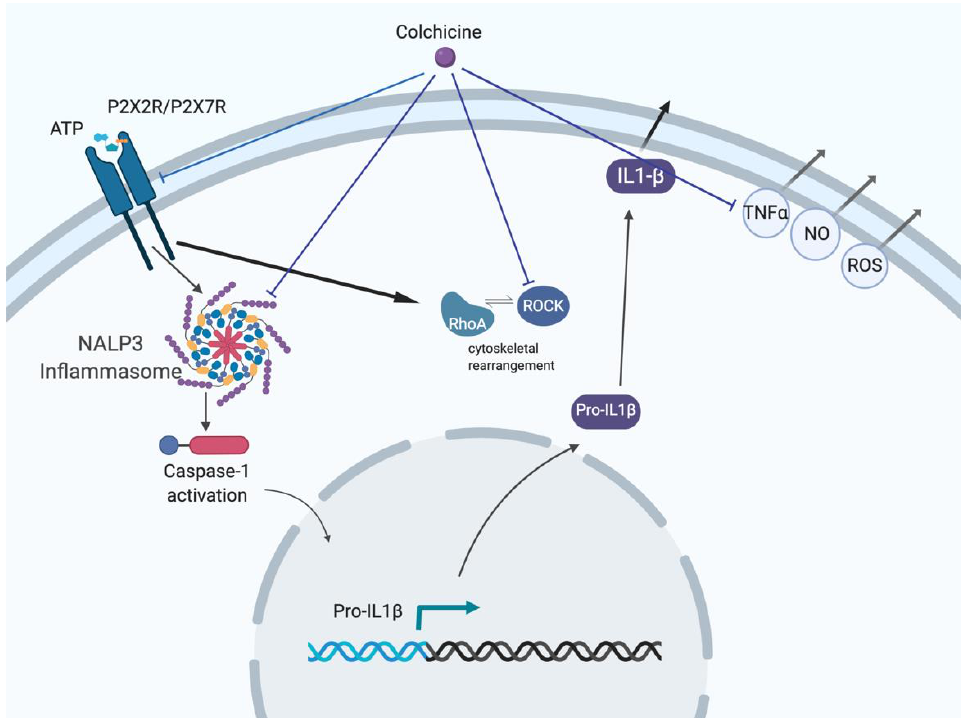
Figure 1. Inhibitory pathway of colchicine. Colchicine inhibits activation of purinergic P2X2/P2X7 receptors and blocks cation uptake and subsequent pro-inflammatory signaling cascades without affecting cell death. Colchicine also inhibits the NALP3 inflammasome pathway, the Rho/ROCK pathway via cytoskeleton rearrangement, and inhibits release of ROS, NO and TNF α . Figure 1 was created using BioRender.com (adapted from [45]).